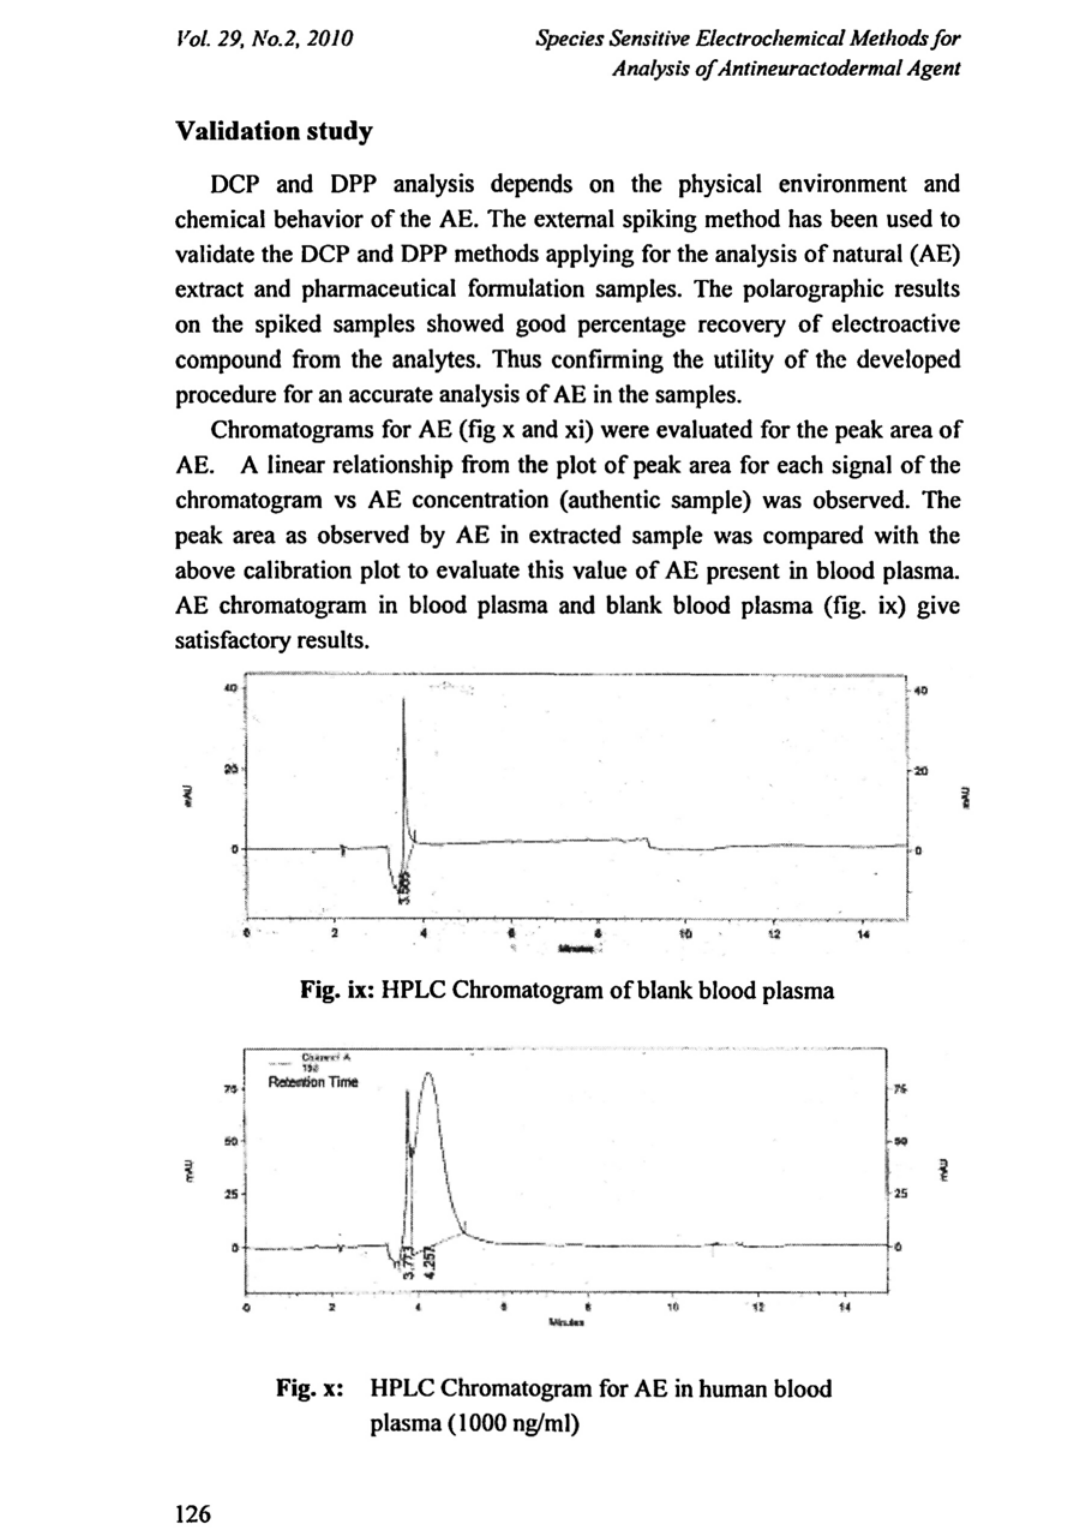
Fig. ix: HPLC Chromatogram of blank blood plasma